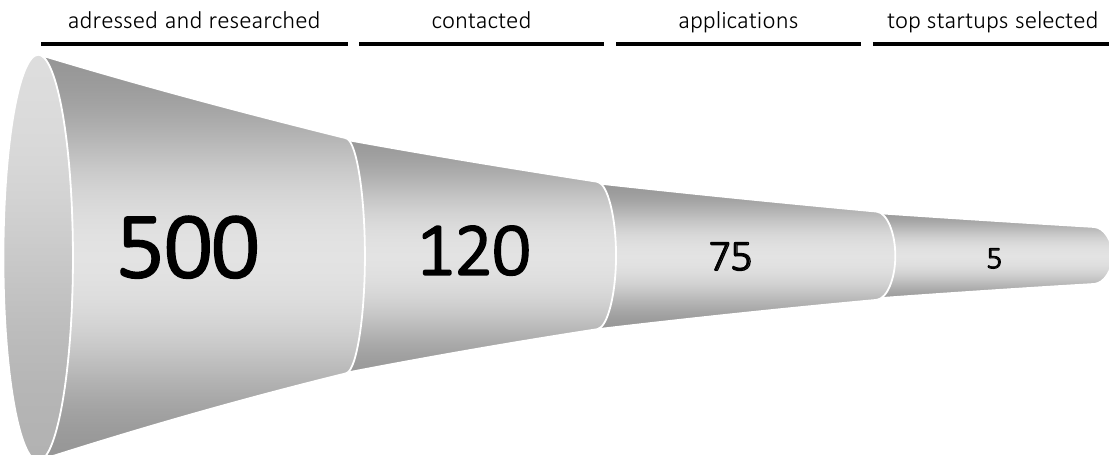
Figure 2. Selection process the Industry 4.0 Startup